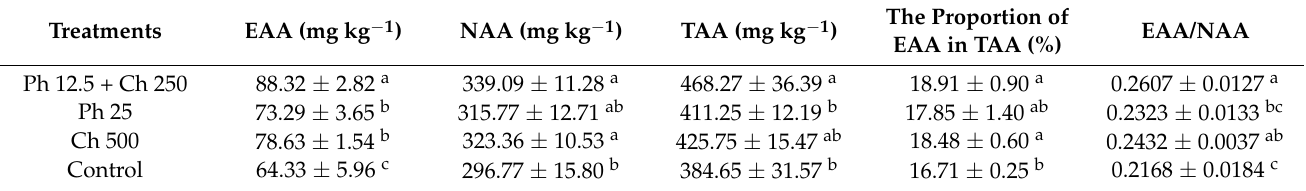
Table 4. The impacts of physcion + chitosan, physcion, and chitosan on fruit amino acids.